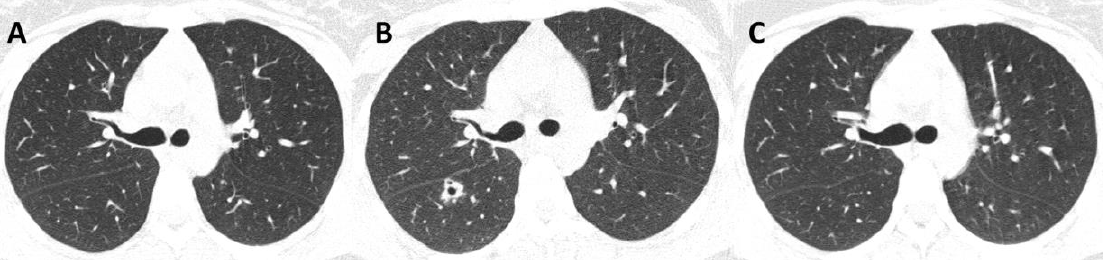
Figure 3. Nonenhanced chest computed tomography (CT) of a 20-year-old woman with disseminated sporotrichosis and lung lesions, at three time points (Case 14). ( A ) During treatment for confirmed pulmonary tuberculosis, CT shows no lung cavities. ( B ) Post-treatment for tuberculosis and recent diagnosis of sporotrichosis, CT shows a thick-walled cavity in the right upper lobe, with isolation of Sporothrix spp. from sputum. ( C ) Resolution of the cavity during sporotrichosis treatment.